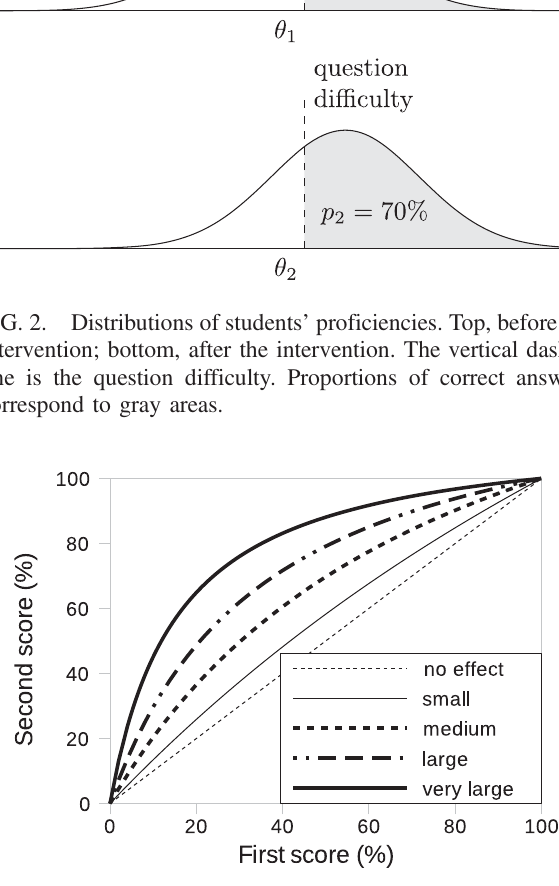
FIG. 3. Isovalues of the Cohen ’ s d effect size (Eq. (6): no effect ( d ¼ 0 ), small ( d ¼ 0 . 2 ), medium ( d ¼ 0 . 5 ), large ( d ¼ 0 . 8 ), and very large ( d ¼ 1 . 2